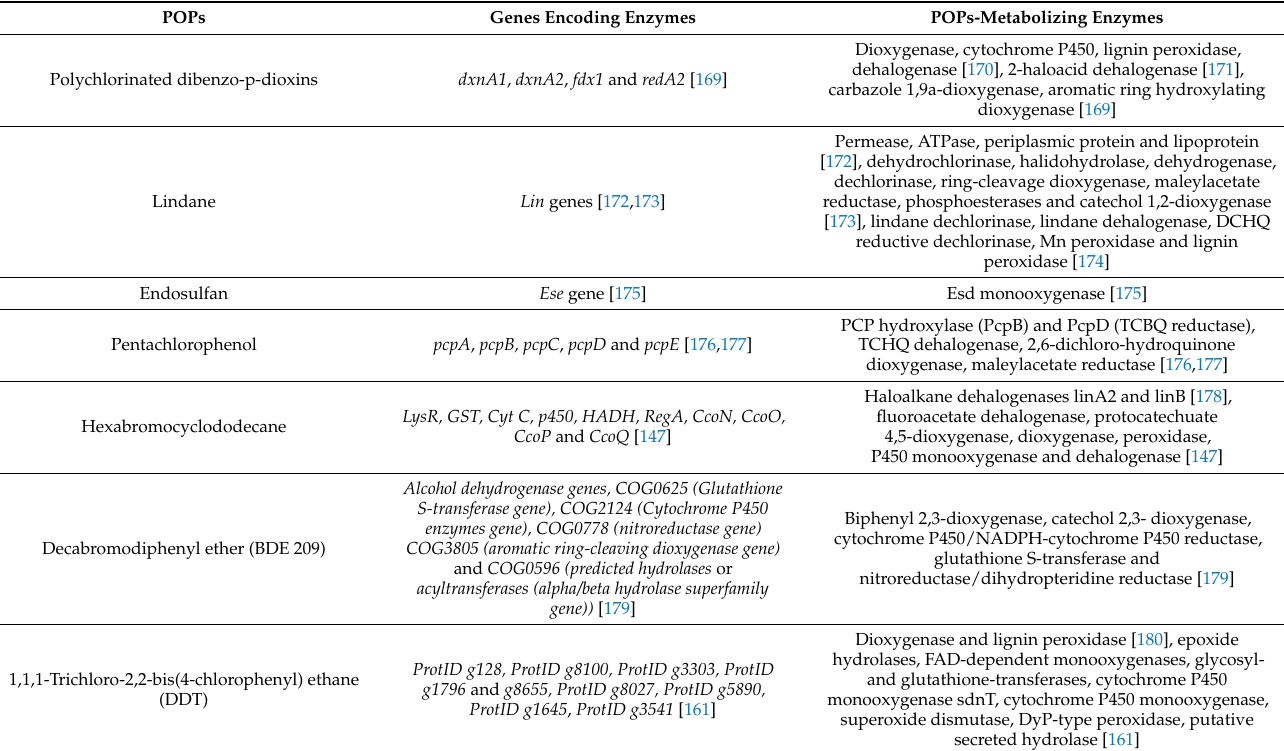
Table 3. The POPs metabolizing enzymes of microbial